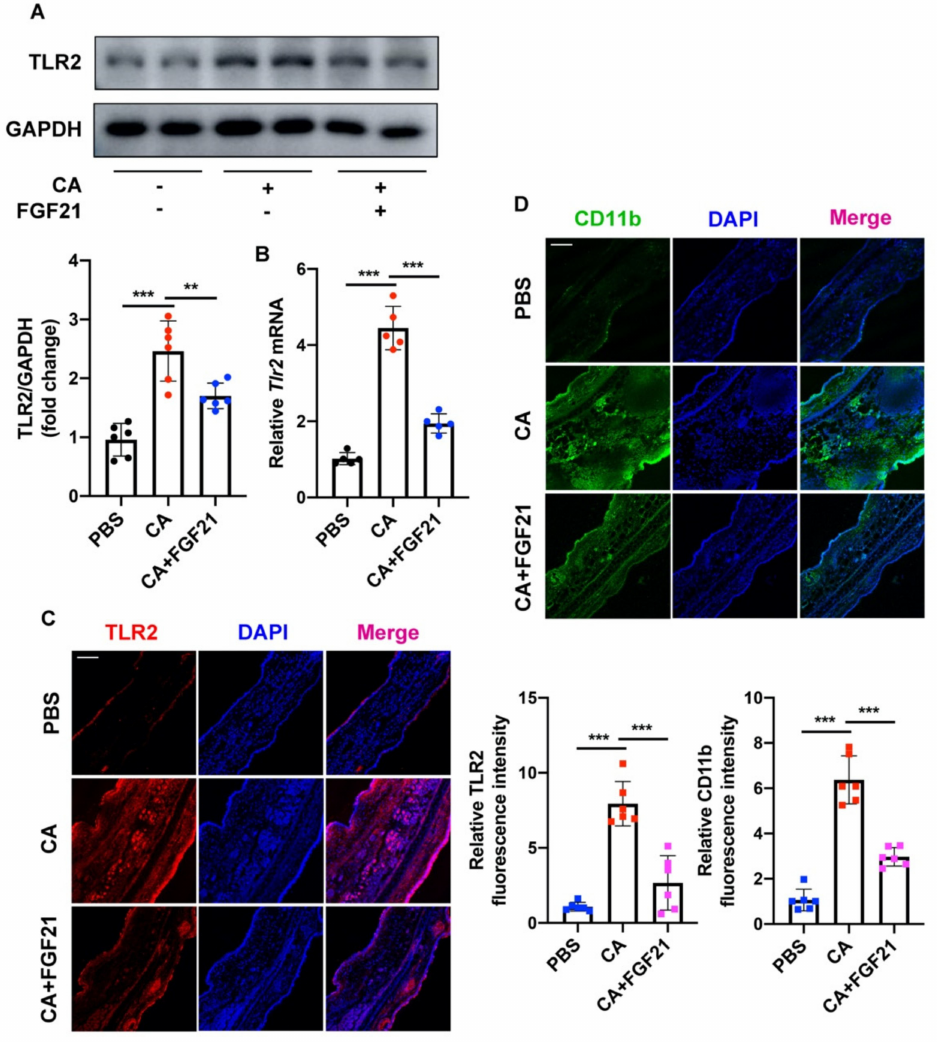
Figure 7. FGF21 alleviation of C. acnes -induced TLR2 in mouse ears. ( A ) Protein expression levels of TLR2 in C. acnes -stimulated mouse ears with and without FGF21 treatment ( n = 6 mice/group). ( B ) Quantification of Tlr2 mRNA level in the ears of mice treated with FGF21 after C. acnes stimulation. ( n = 5 mice/group). ( C , D ) Representative confocal scans are shown for TLR2 (red) and CD11b (green), and the nuclei are stained with DAPI (blue) ( n = 6 mice/group). Scale bar = 100 µ m. All data are presented as the mean ± the SD; ** p < 0.01, and *** p <